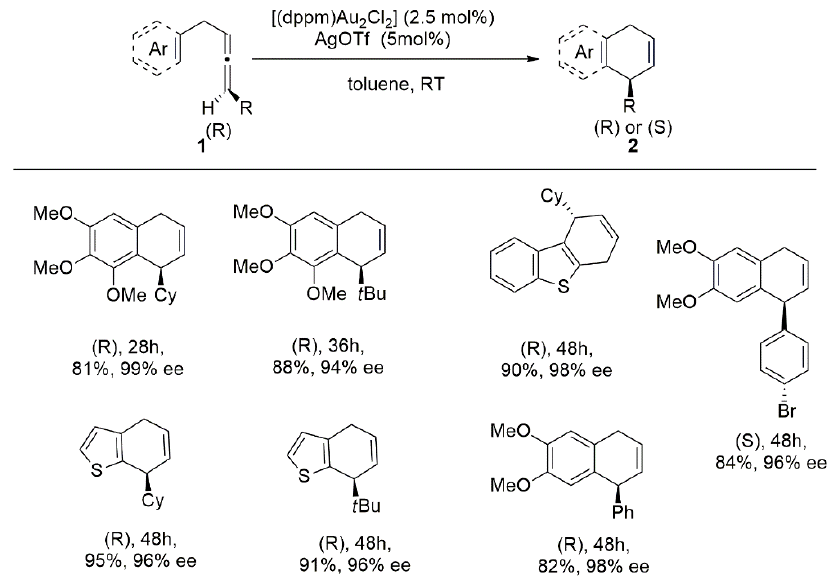
Figure 1. Asymmetric hydroarylation of enantioenriched allenes ( 1 ) by using dinuclear [(dppm)Au 2 Cl 2 ]/AgOTf catalytic